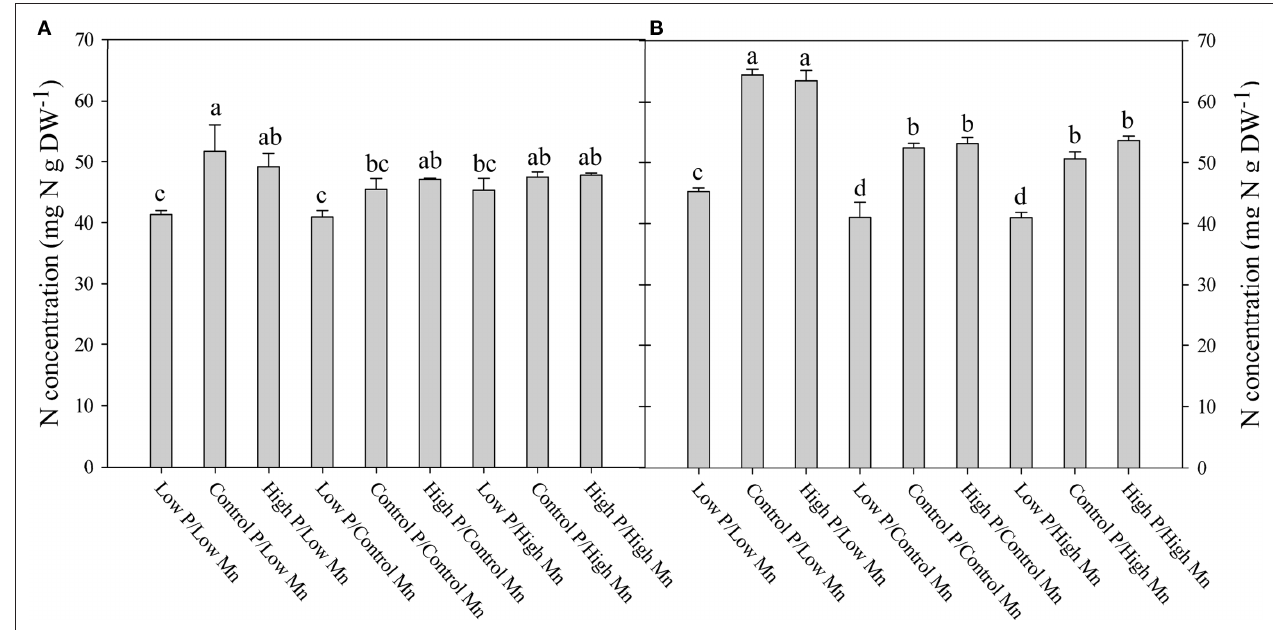
FIgure A2 | The concentration of nitrogen (N) in the youngest fully emerged leaf of the Mn-inefficient genotype Antonia (A) and Mn-efficient genotype Vanessa (B) grown in hydroponics at different Mn and P levels. Different letters above columns mark significant differences between treatments ( P > 0.05). Data are means ± SE ( n